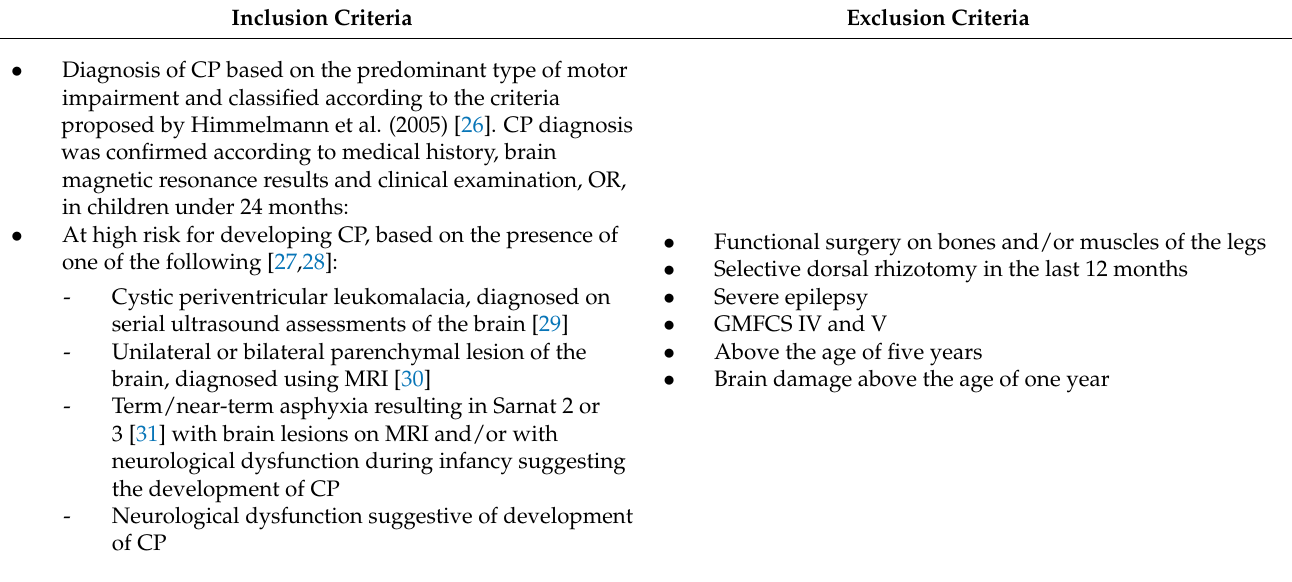
Table 1. In- and exclusion criteria for the CP